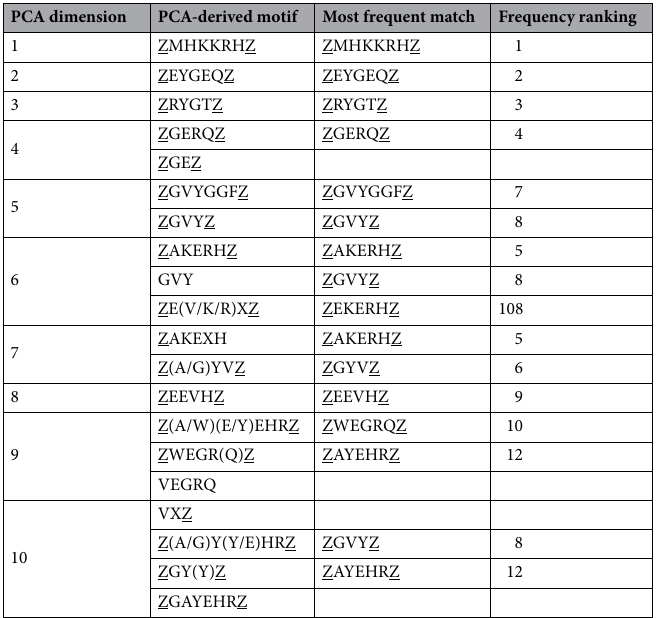
Table 2. Comparison of PCA-derived enriched sequences and NGS read frequency for the 2nd round library. Motifs were reconstructed for the first 10 PCA dimensions and used to search the NGS results for the ranking of the highest enriched sequences (highest Z-scores). Because the second round post-selection library was significantly smaller and heavily biased, correlation between PCA and NGS frequency is very good. Some sequence variation and small motifs can still be